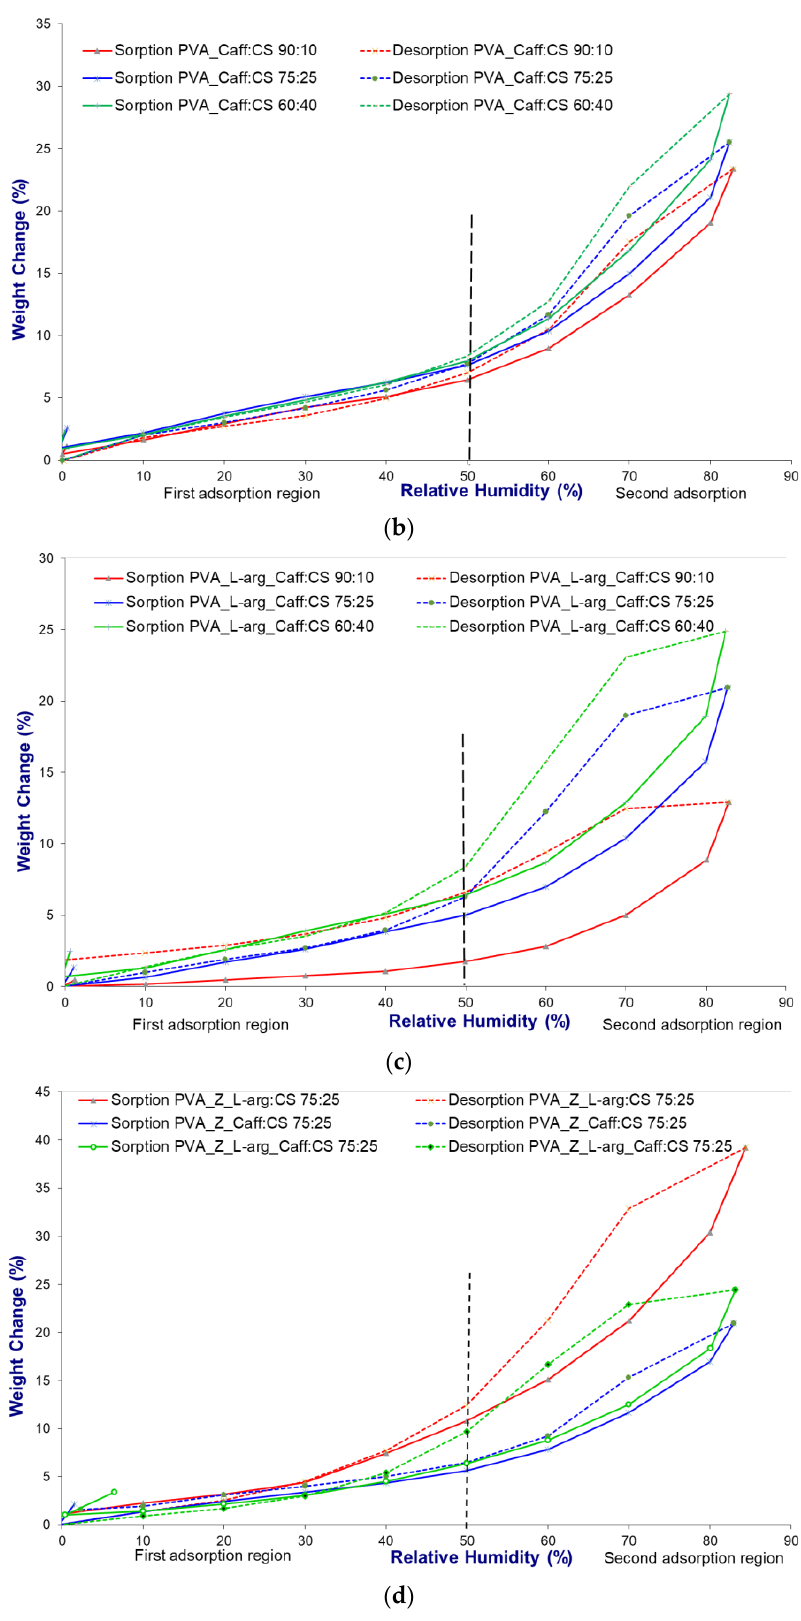
Figure 3. Sorption/desorption isotherms of hydrogels ( a ) loaded with L-arginine, ( b ) loaded with caffeine, ( c ) loaded with L-arginine and caffeine mixture, and ( d ) containing zeolite and polymer ratio PVA:CS 75:25.